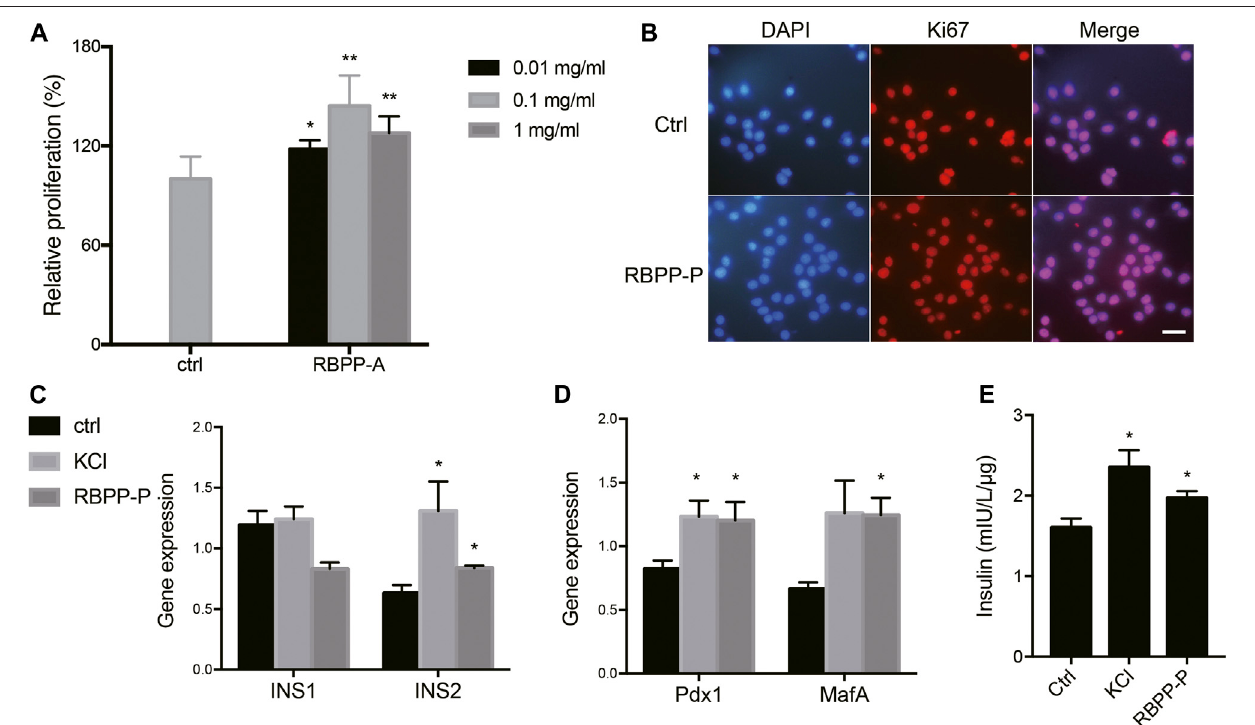
FIGURE 2 | Effects of RBPP-P on cell viability, insulin gene expression and insulin secretion. (A) RBPP-P promoted cell proliferation by MTT assay ( n (cid:1) 5). (B) RBPP-PpromotedcellproliferationbyKi-67immunostaining( n (cid:1) 10).Scalebar,100 μ m. (C) qRT-PCRwasusedtoevaluatetheIns1andIns2levelsinMin6cells( n (cid:1) 5). (D) qRT-PCRwasusedtoevaluatethePdx1andMafAlevelsinMin6cells( n (cid:1) 5).mRNAlevelswerenormalizedtoGapdhmRNA. (E) InsulinsecretionlevelsinMin6cells ( n (cid:1) 5). All data are expressed as mean ± s. d. *p < 0.05, ** p < 0.01, vs. control.